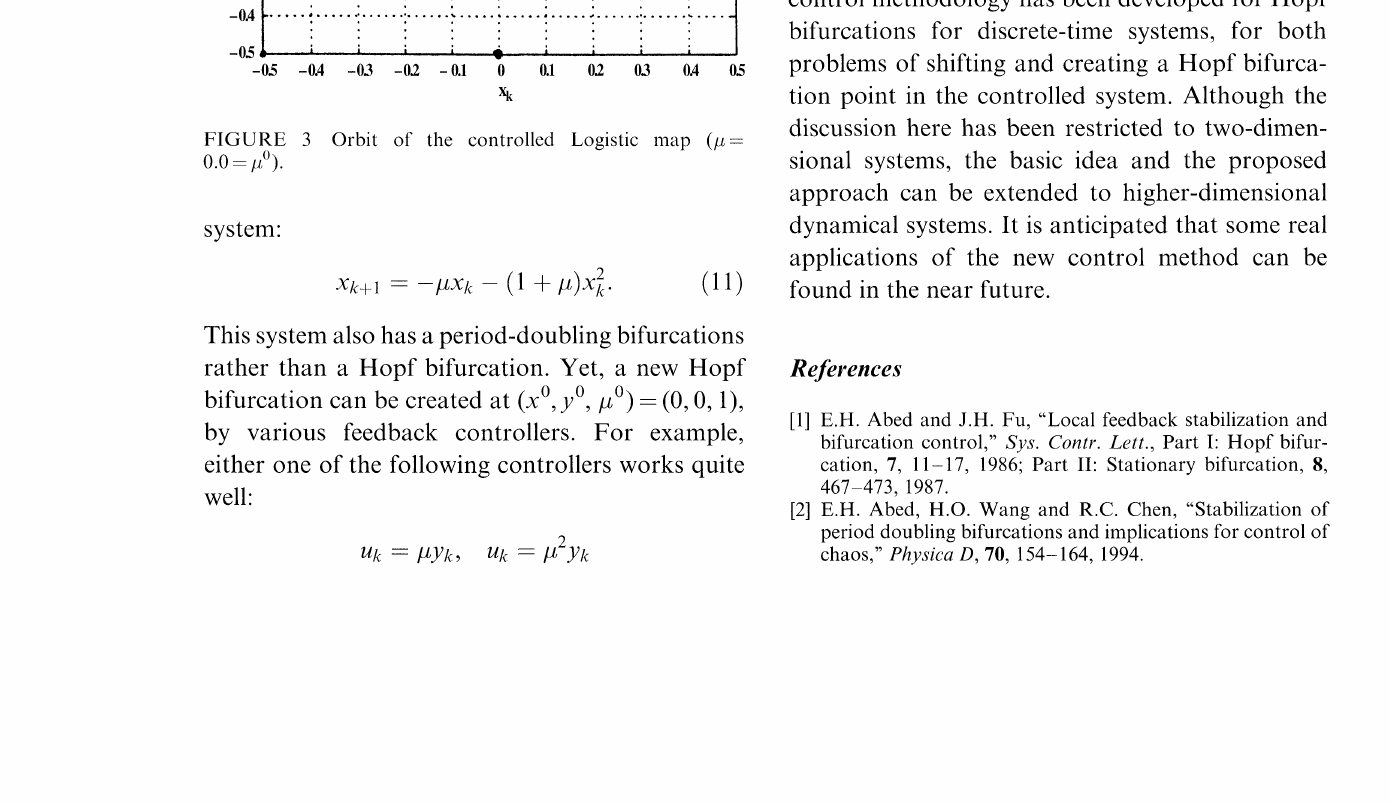
FIGURE 2 Orbit of the controlled Logistic map (#= -0.01 < 0.0 #).